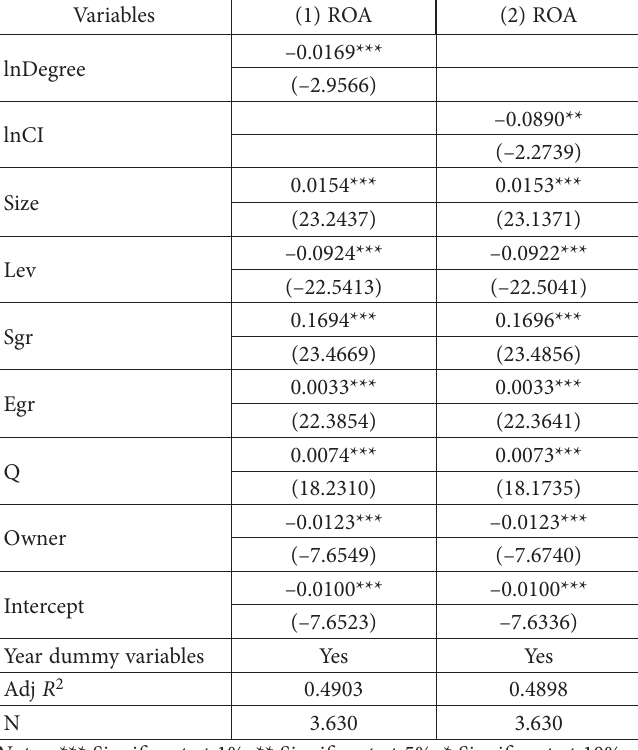
Table 2. Network centrality, structural holes, and firm